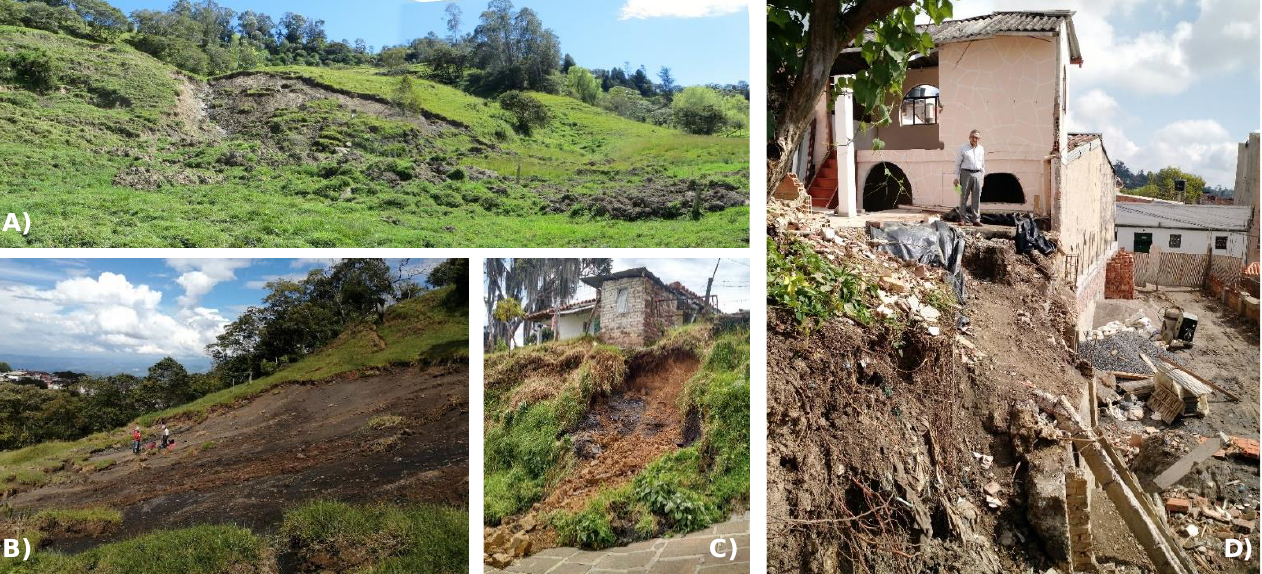
Figure 10. Mass movements present in the jurisdiction of the municipality of Vélez: ( A ) Earth flow seen in the Troncal del Carare road corridor, which started as translational type and in paddock grounds; ( B ) laminar landslide just to the west of the study area (seen in the background, on the Palenque ravine), which laminarly mobilized the regolith at the end of August 2020; ( C ) debris wedge slide on the road cut slope between Aquileo Parra and Kennedy neighborhoods (activated in October 2016). ( D ) Removal caused by excavations for a shopping center in the Las Nieves neighborhood, which affected 3 houses and forced the suspension of the project (February 2017); it exposed a thick and ancient soil profile that had zeolites and abundant alteration clays.